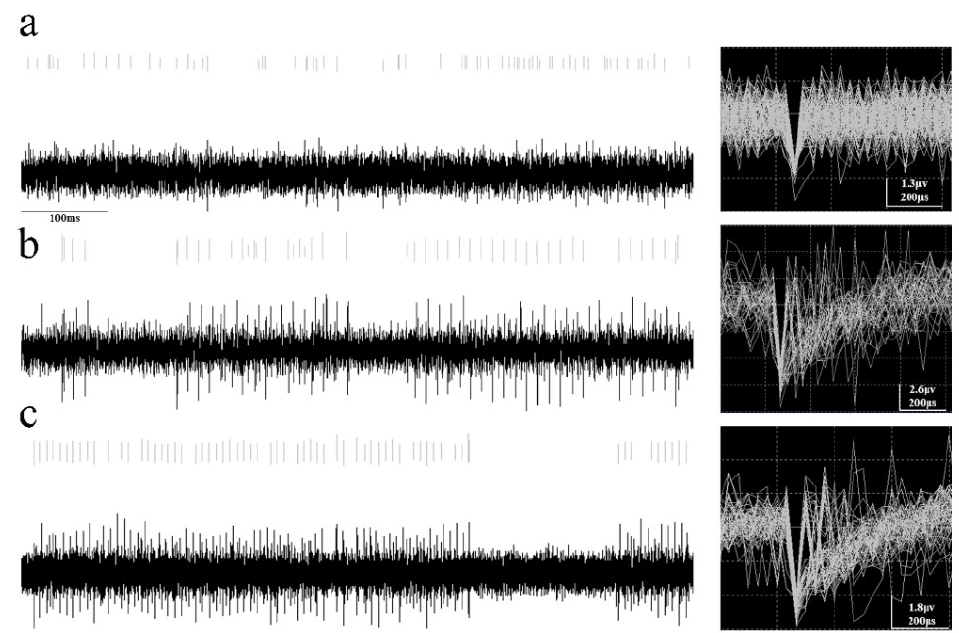
Figure 4. Membrane potential changes were recorded from attached taste bud organoids via the MEA chip ( a ) when no stimulus, ( b ) acid stimulus (10 mM citric acid), and ( c ) salty stimulus (100 mM NaCl) were applied separately. The left column presents the original recording signals, showing the patterns of firing spikes via grating. The right column shows the results of the clustering of recorded spikes from the original recordings.